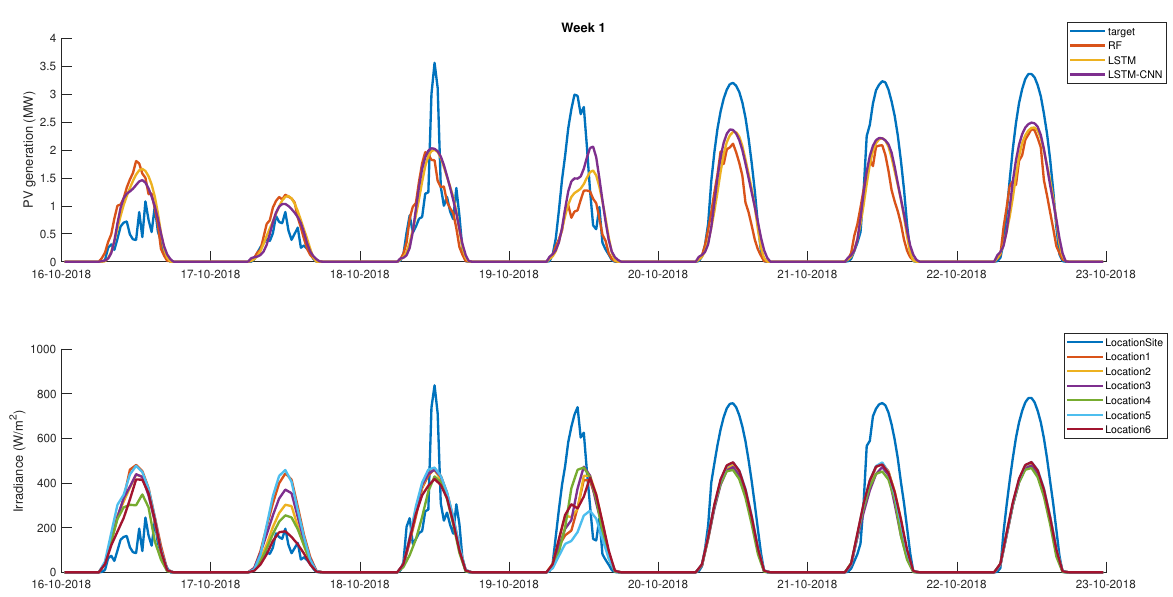
Figure 11. The top plot shows the target and predicted PV power for week 1, while the bottom plot shows the irradiance measured at the location of the solar panel (which is not available for the prediction) and the irradiance obtained from the weather data at the other geographically spread locations (used in the prediction